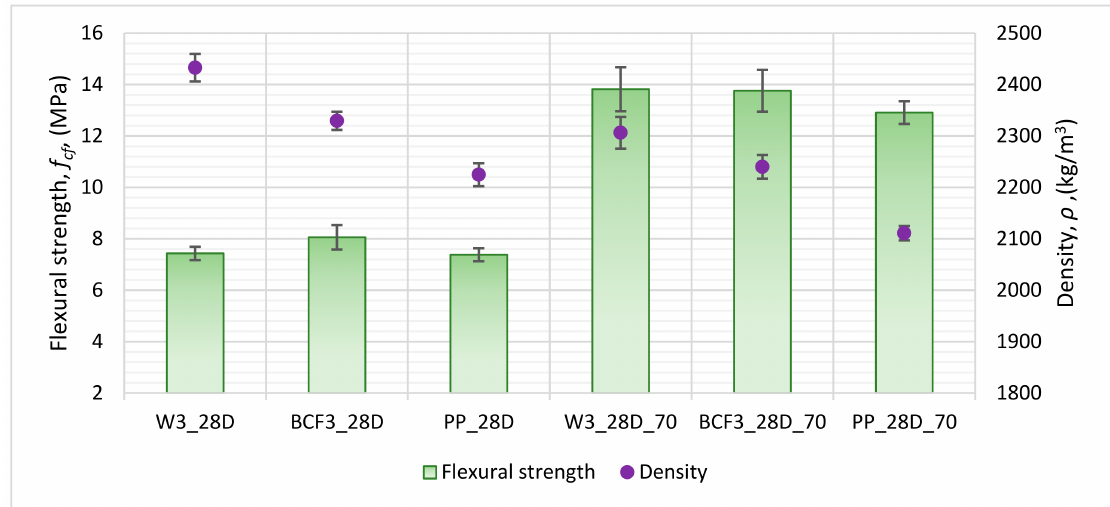
Figure 6. Influence of drying until stable mass on flexural strength and density of cement mortars with various types of fibres (for conditioning descriptions, see Table